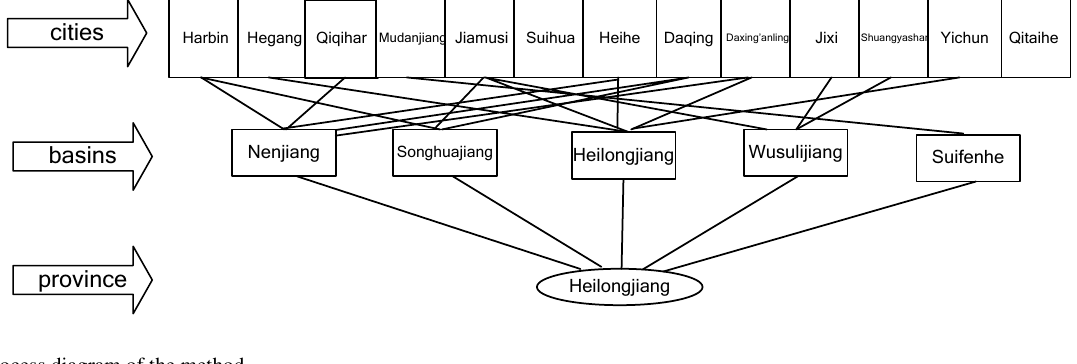
Fig. 2 Process diagram of the